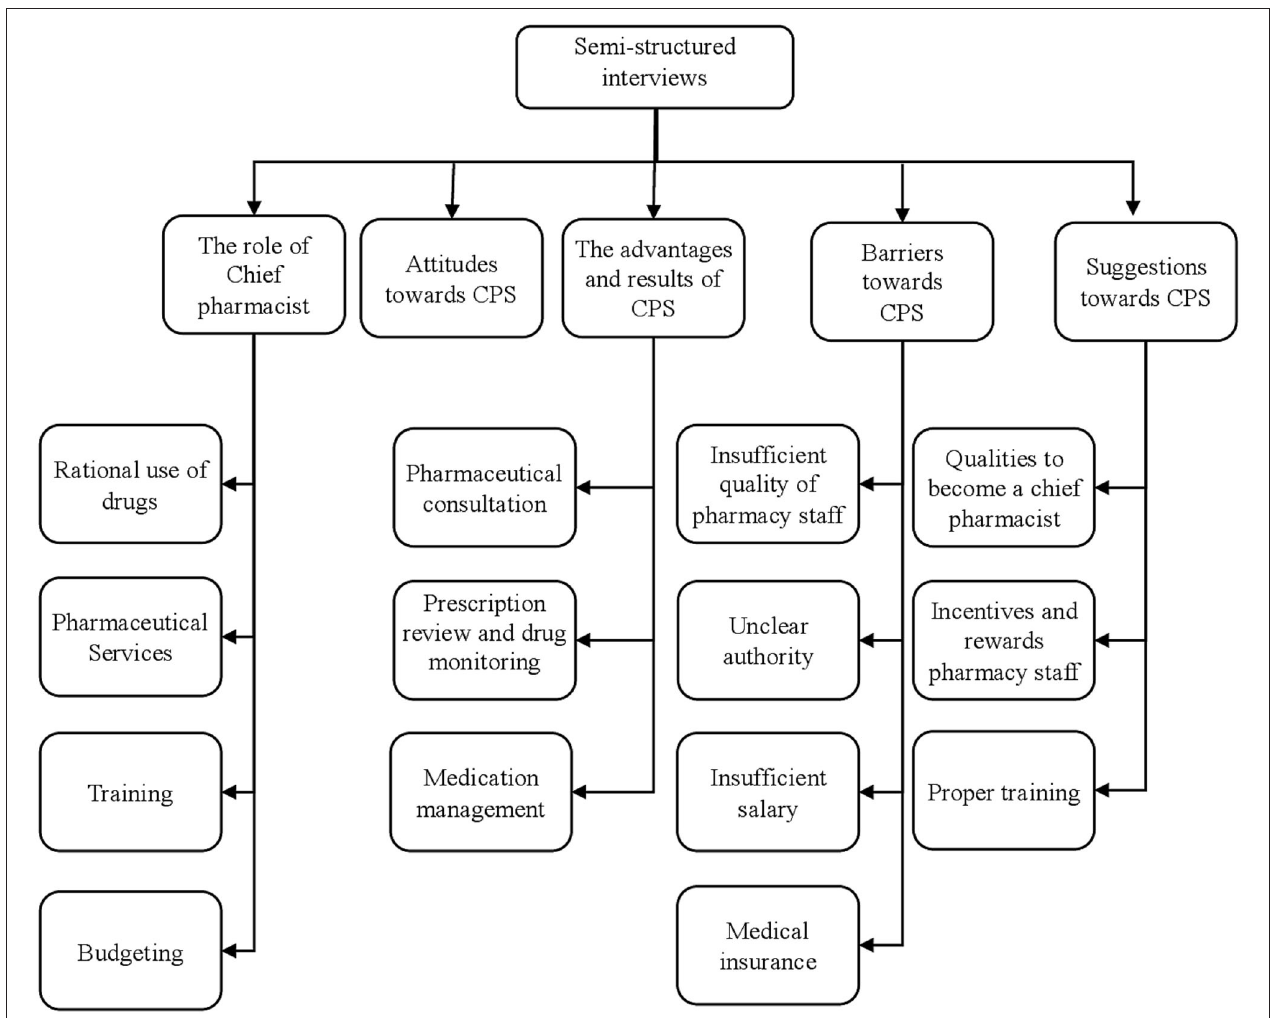
FIGURE 1 | Summary of emerged themes and